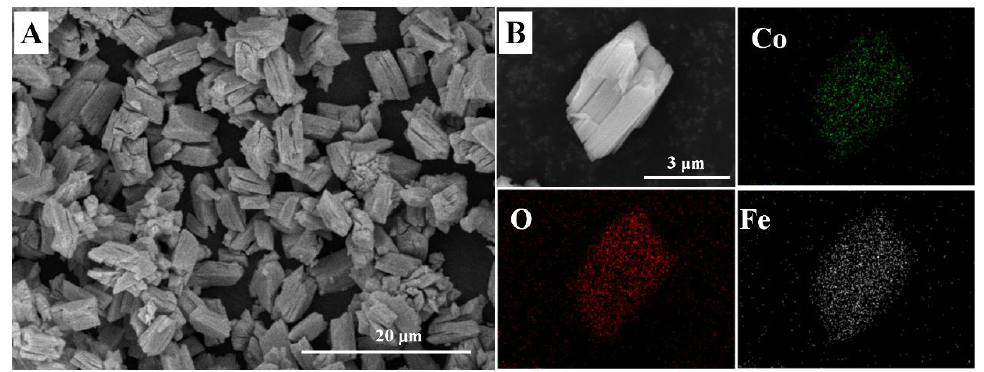
Figure 2. ( A ) SEM image of CF300 and ( B ) EDX elemental mappings.